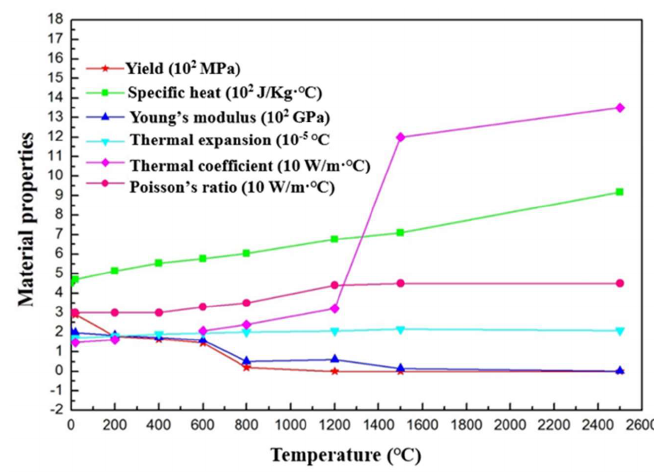
Figure 3. Thermal and mechanical properties of 06Cr19Ni10 steel.